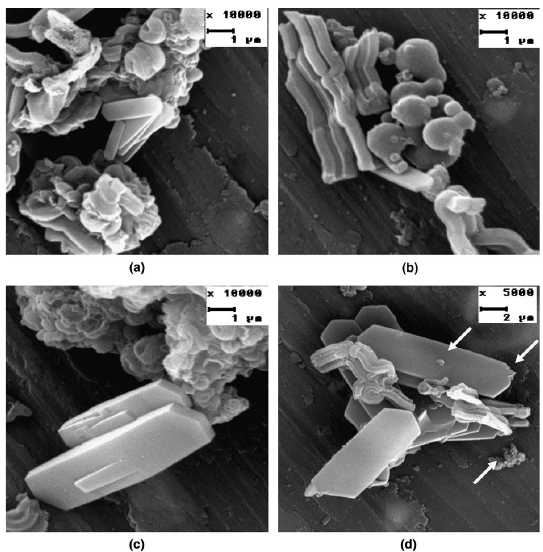
Fig. 9. SEM micrographs of sample: (a) T24, (b) T48, (c) T60 and (d) T72. Figure 8. SEM images of zeolitization of SBA-15 into ZSM-5 for different crystallization time: ( a ) 24 h, ( b ) 48 h, ( c ) 60 h, and ( d ) 72 h. The white arrows show the segregated ZSM-5 crystals [77]. This figure was published in Microporous Mesoporous Mater., Vol. 95, Campos, A.A.; Dimitrov, L.; da Silva, C.R.;